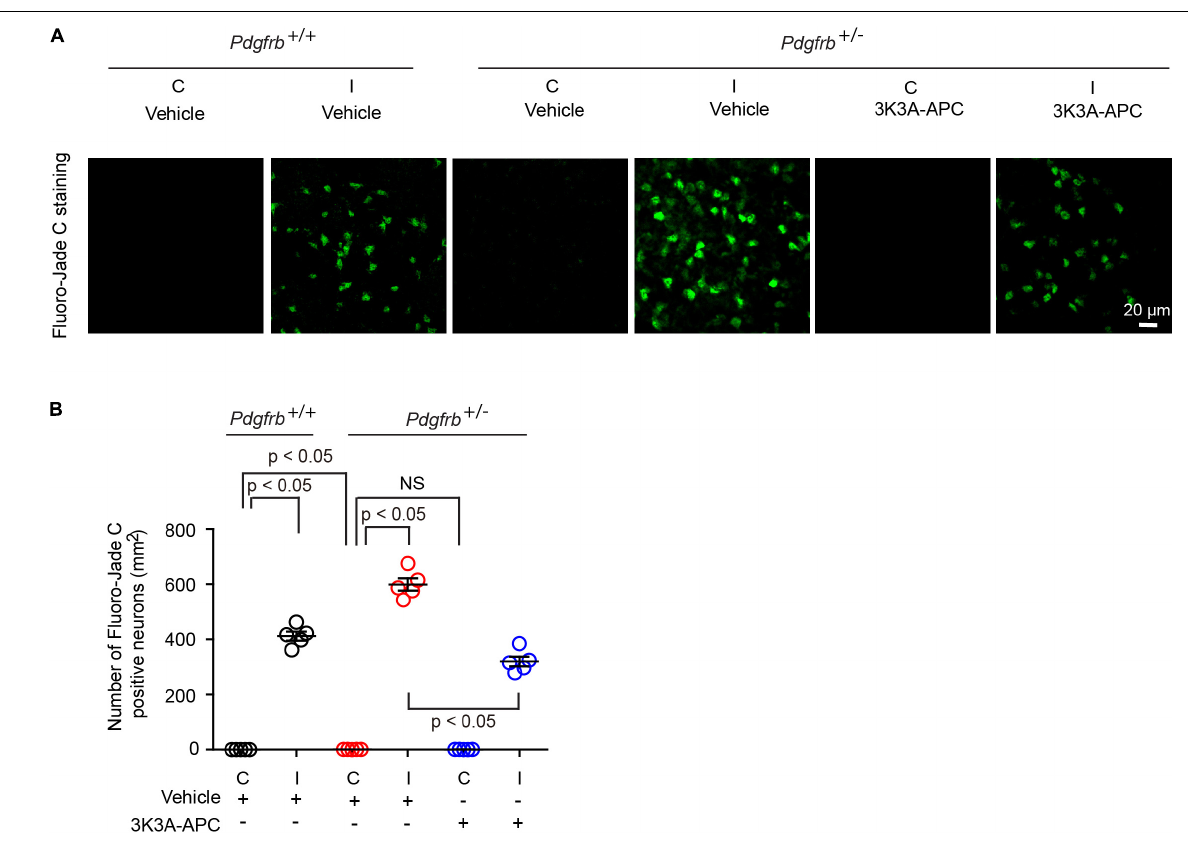
FIGURE 4 | 3K3A-APC reduces post-ischemic neurodegeneration in pericyte-deficient Pdgfrb + / − mice. (A) Fluoro-Jade C staining in non-ischemic contralateral cortex (“C”) and ischemic core of the ipsilateral cortex (“I”) 24 h after tMCAo in Pdgfrb + / + mice and Pdgfrb + / − mice treated with vehicle or 3K3A-APC. (B) Quantification of Fluoro-Jade C + neurons in non-ischemic contralateral cortex (“C”) and ischemic core of the ipsilateral cortex (“I”) 24 h after tMCAo in Pdgfrb + / + mice and Pdgfrb + / − mice treated with vehicle or 3K3A-APC. Mean ± SEM, n = 5 mice per group. The p -values were calculated by one-way ANOVA followed by Tukey’s multiple comparisons